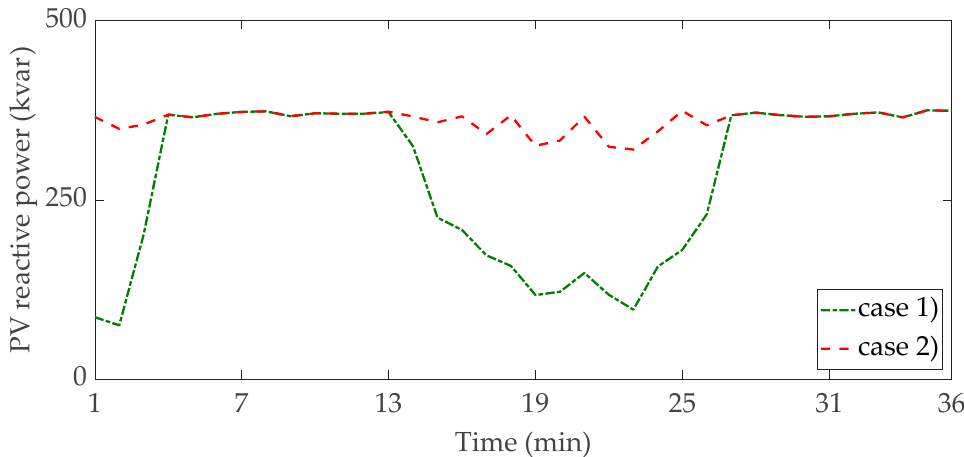
Figure 13. Reactive power profile of the PV located at bus #15 in the three case studies.